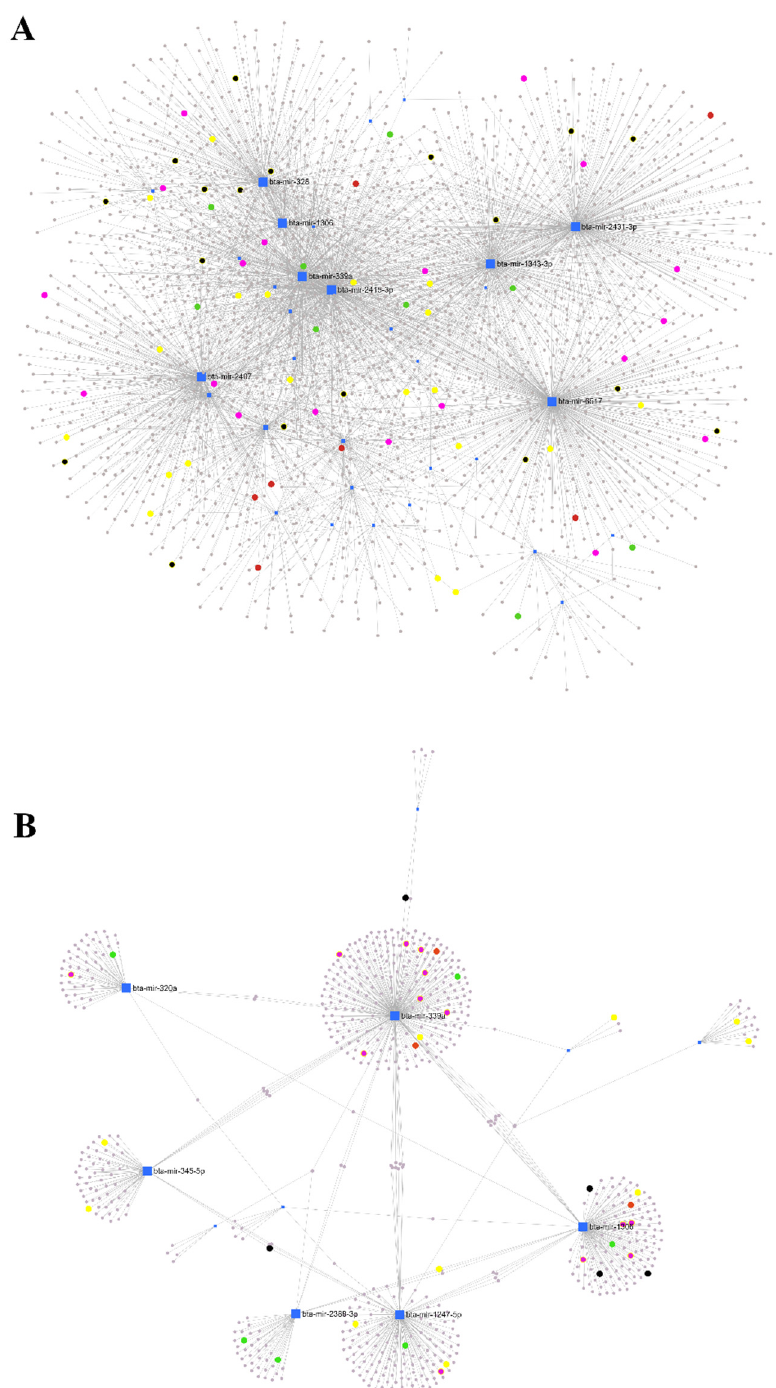
Figure 4. Network analysis of miRNA differentially expressed between healthy (H) cows, cows at risk of mastitis (ARM), and cows with subclinical mastitis (SCM). Figures were generated by miRNet suite [50]. ( A ) H_ARM comparison: in red are the genes of the NF-KB signaling pathway; in green the genes of the T cell receptor signaling pathway; in yellow the genes of the TNF signaling pathway; in purple the genes of the leukocyte transendothelial migration; and in black the genes of the adherens junction. ( B ) H_SCM comparison: in red are the genes of the NOD-like signaling pathway; in green the genes of the T cell receptor signaling pathway; in yellow the genes of the TNF signaling pathway; in purple the genes of the leukocyte transendothelial migration; in black the genes of the adherens junction. (Supplementary Table S4 reports the miRNAs in the